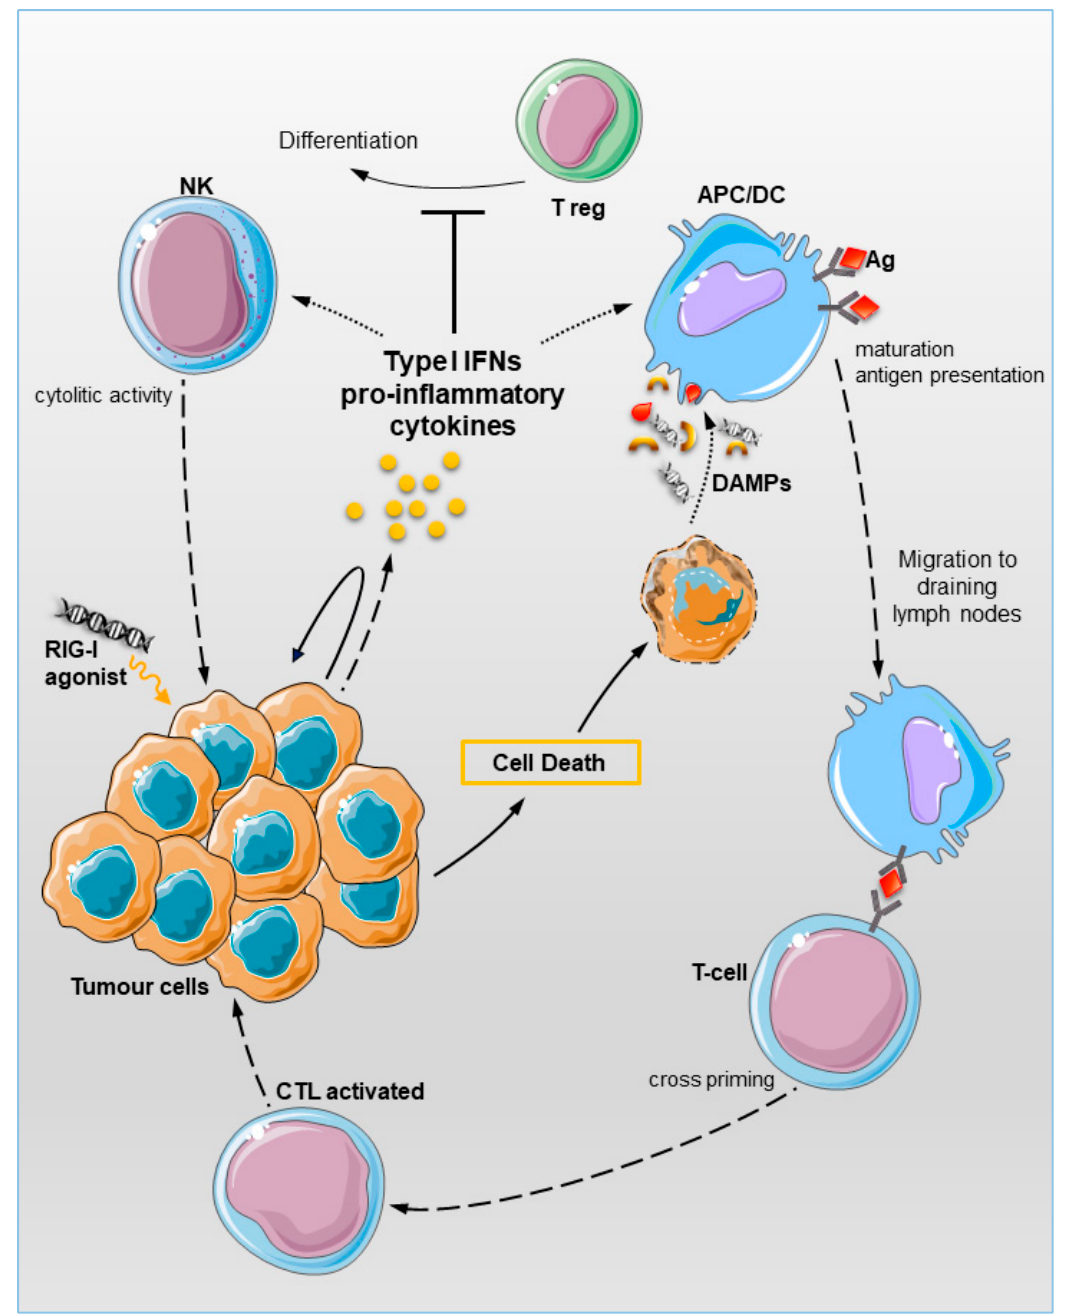
Figure 2. Working model of RIG-I pathway activation in the tumour microenvironment (TME). Activation of RIG-I signalling pathway in the tumour cells leads to type I IFN-driven immune response and preferential activation of programmed tumour cell death. Both the cytolytic activity of natural killer (NK) cells and phagocytic potential of macrophages are increased, while the T-regulatory cell differentiation was reduced in response to type I IFN-enriched microenvironment. Maturation of DCs will result in enhanced CD8 + T-lymphocytes cross-priming in tumour draining lymph nodes. RIG-I, retinoic acid induced gene 1; IFN, interferon; NK, natural killer; DC, dendritic cell; TME, tumour microenvironment.